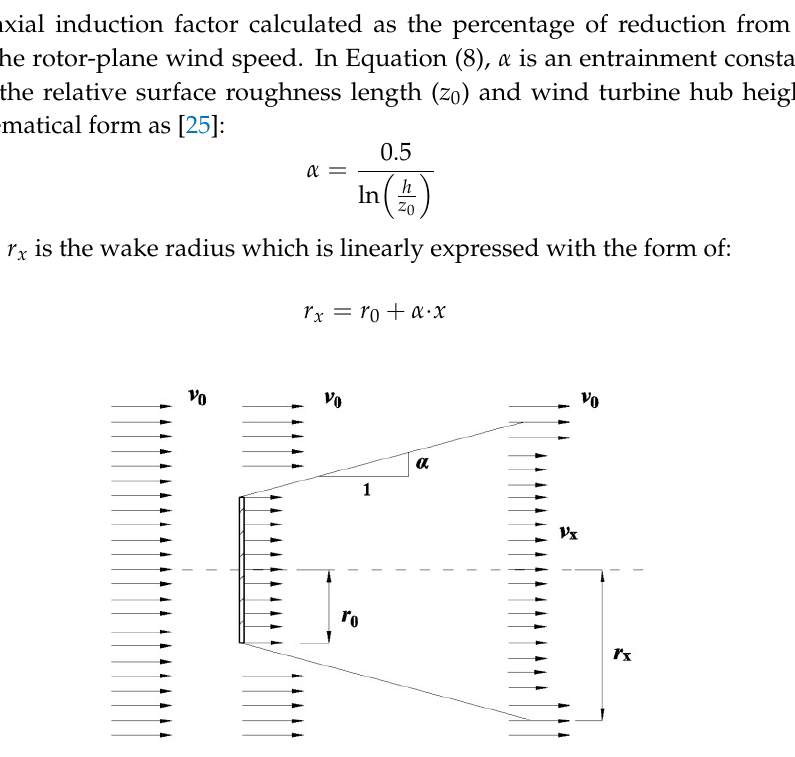
Figure 2. Diagram of one-dimensional Jensen’s wake model.